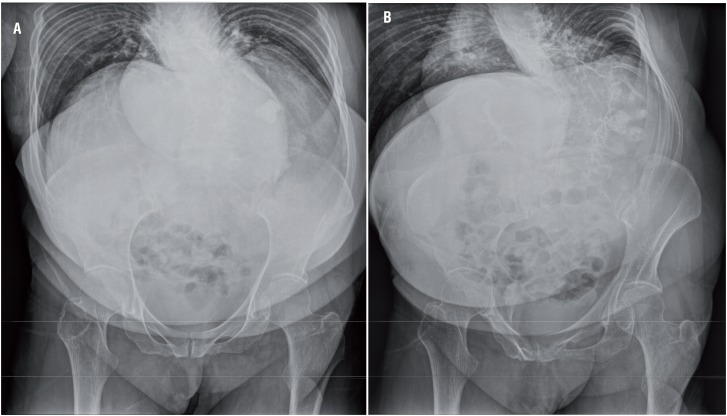
A plain abdominal film (KUB) and IVU show a pelvic and lower calycial stone in left kidney with a good function in a posterior thoracolumbar spinal kyphoscoliosis complicated with chest deformity patient.